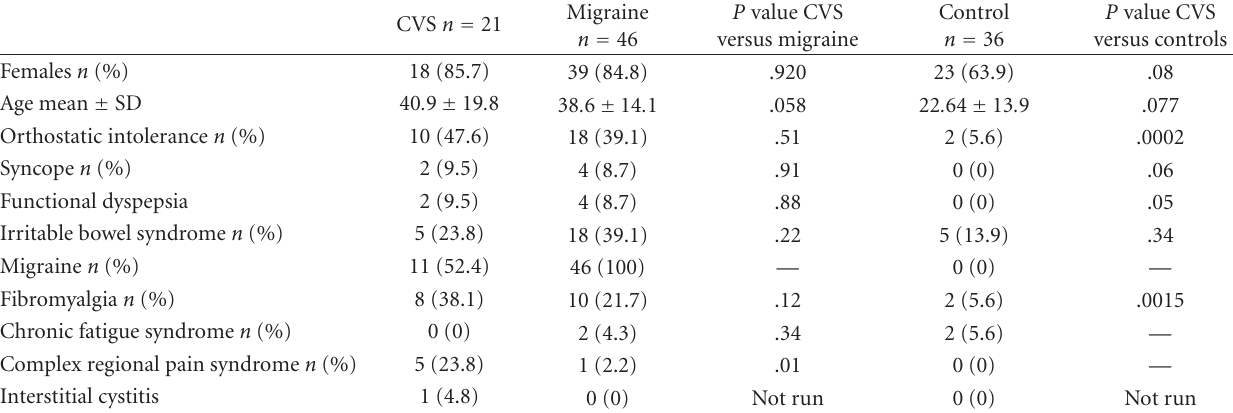
Table 2: Autonomic co-morbidities in Cyclic Vomiting Syndrome (CVS), migraine, and healthy